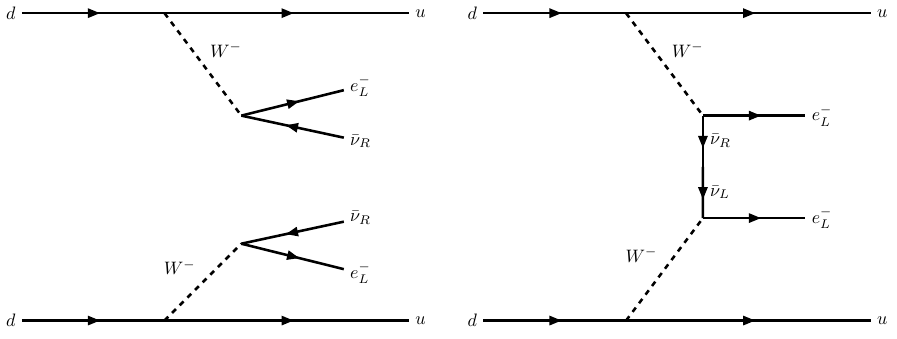
Figure 1. The Feynman diagram of 2 νββ ( left ) and 0 νββ ( right ). The DBD fingerprint in experiments is a continuous spectrum ending up at the nuclear transition Q value ( Q ββ ) for the 2 νββ and a monochromatic line at Q ββ for the 0 νββ , as shown in Figure 2: for 76 Ge the Q ββ is at 2039.15 keV.